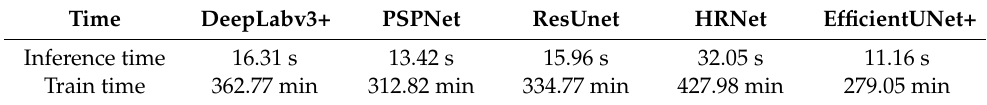
Figure 15. Visualization graph of training loss and epochs. Table 7. Operation time of buildings extracted by different methods.